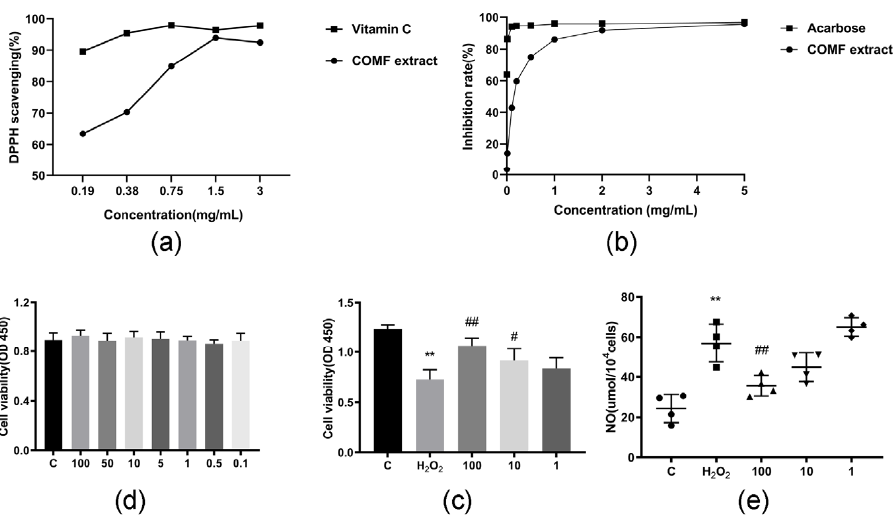
Figure 3. COMF extract in vitro activity assay. ( a ) DPPH clearance rate of COMF extract and ascorbic acid (positive control) at different concentrations (%); ( b ) inhibitory rate of acarbose (positive control) and COMF extract on α -glucosidase (%); ( c ) cell activity as measured by CCK-8 kit. HUVECs were not damaged by hydrogen peroxide; ( d ) cell activity as measured by CCK-8 kit. HUVECs are hydrogen peroxide-stimulated cells; ( e ) NO content in HUVECs. (Using NO assay kit). * represents a significant difference from group C (blank group), ** indicates p < 0.01. # represents a significant difference compared with H 2 O 2 group (model group), # indicates p < 0.05 and ## indicates p < 0.01.